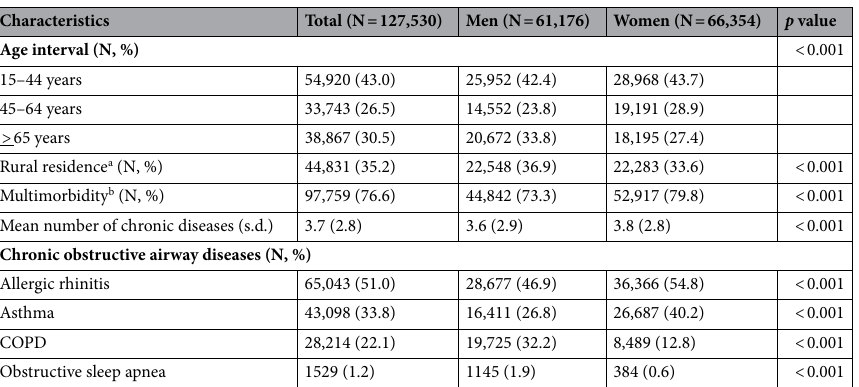
Table 1. Demographical and clinical characteristics of patients with chronic obstructive airway diseases. s.d. standard deviation, COPD chronic obstructive pulmonary disease. a Versus urban residence. b Defined as the simultaneous presence of two or more chronic diseases from a list of 114 conditions, including each chronic obstructive airway disease